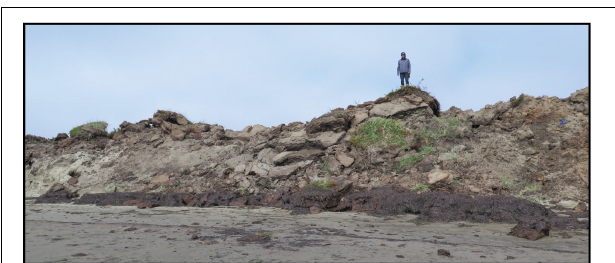
FIGURE 1 | Remnants of the ivu along the eastern portion of coastline as observed on July 22, 2017, 7 months after its occurrence. The ivu eroded nearshore and bluff sediments placing them in large piles along the coastline. A member of the science party is shown for